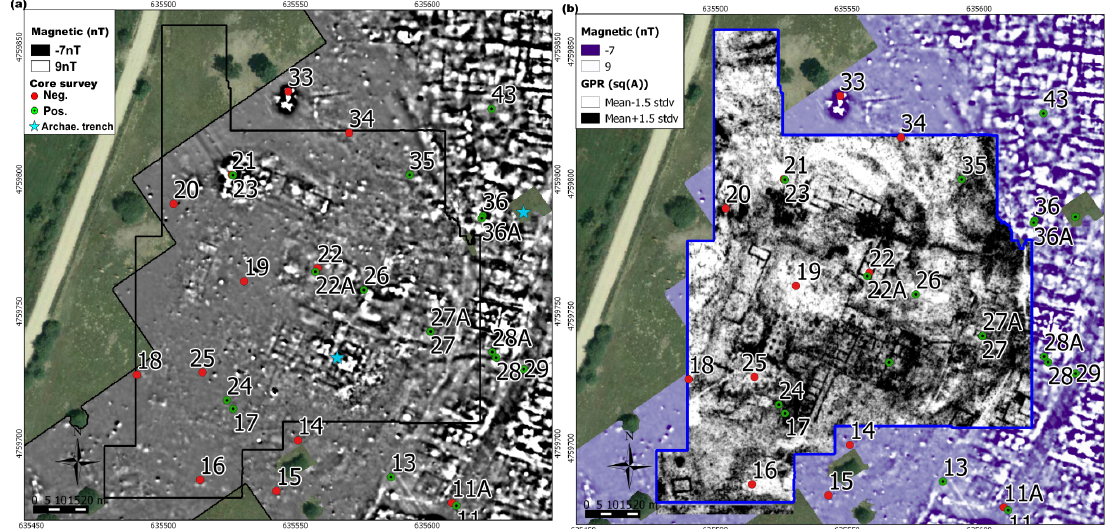
Figure 11. P5 area. ( a ) Location of cores over the magnetic data; ( b ) Location of the cores over